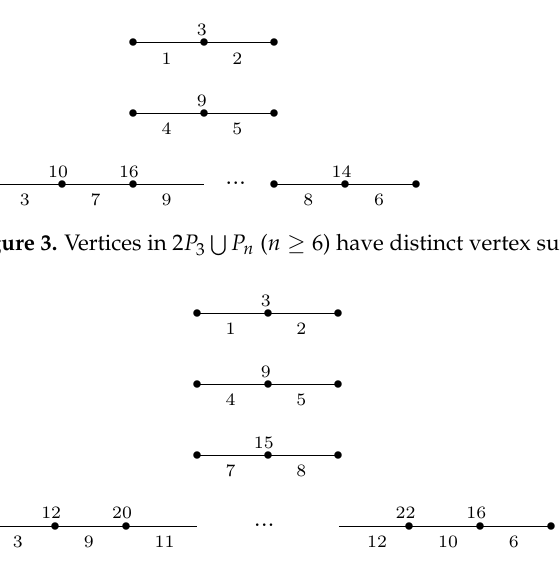
P n ( n 7) have distinct vertex sums, except for f + ( z 1 ) = f + ( u 1 ) = ≥ (cid:83)